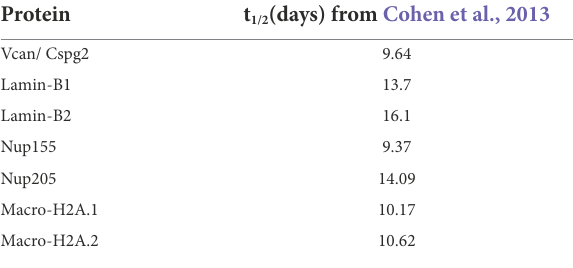
TABLE 1 Abundant long-lived proteins used for normalization. Protein t 1/2 (days) from Cohen et al., 2013